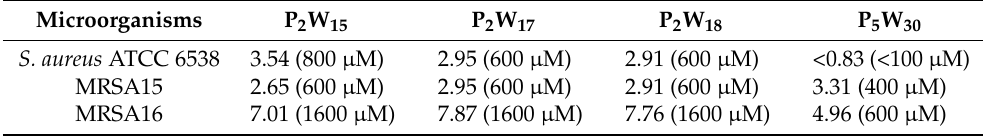
Table 3. MIC values for the tested polyoxotungstates (mg · mL − 1